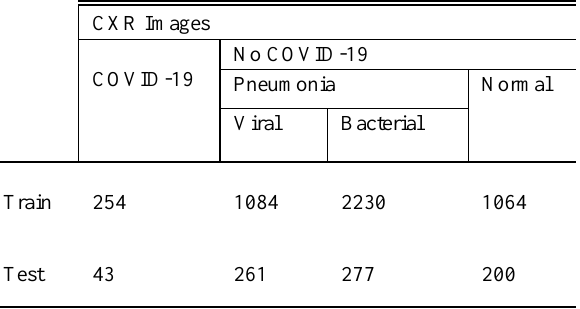
accuracy, sensitivity, and specificity is given in Table 3.